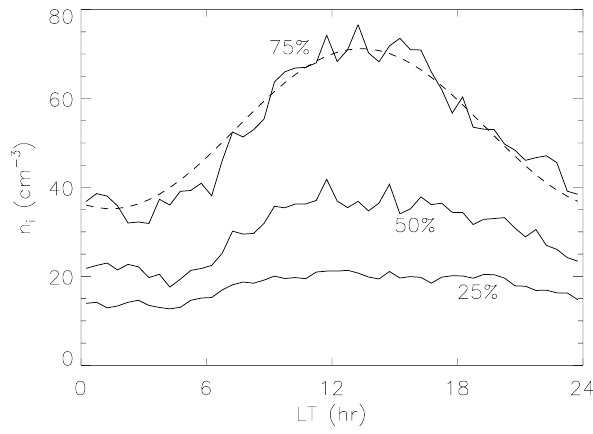
Fig. 3. Occurrence frequency of density measurements summed over local time as a function of density. All half-hour bins show a similar behavior. The bin width here is 0.25cm − 3 . The dotted lines are the best linear fits to the data for n < 5cm − 3 and n > 20cm − 3 .